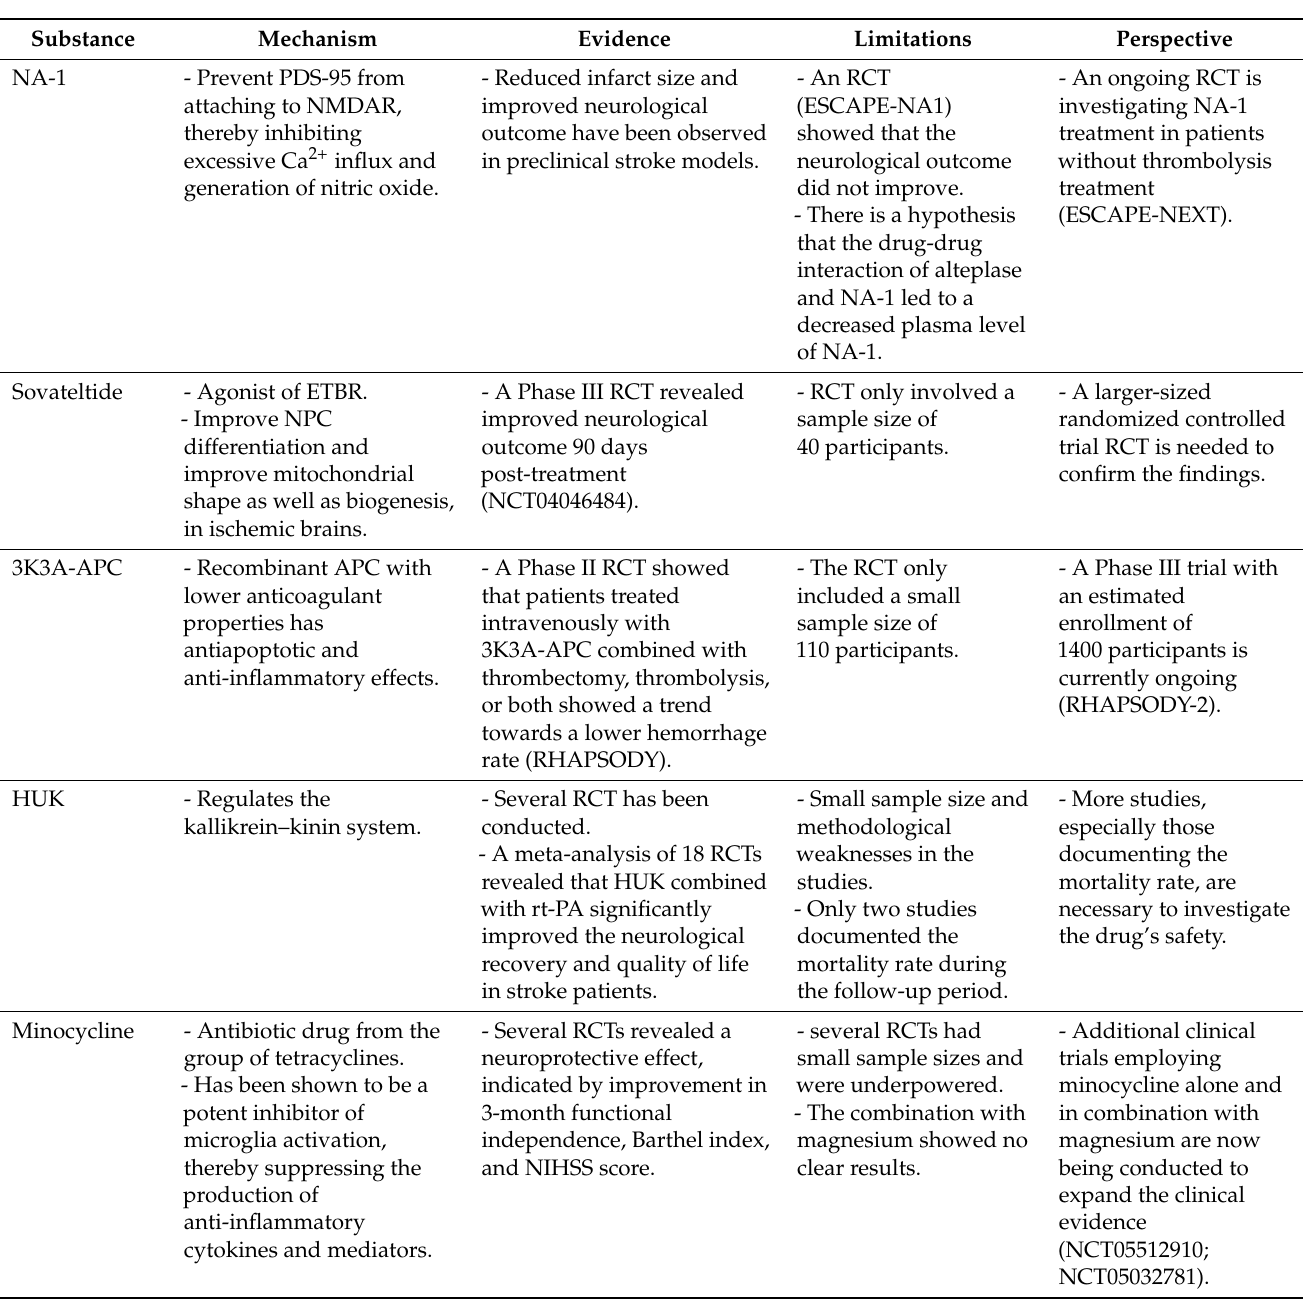
Table 1. Promising neuroprotective Candidates. Abbreviations: APC: Activated Protein C;